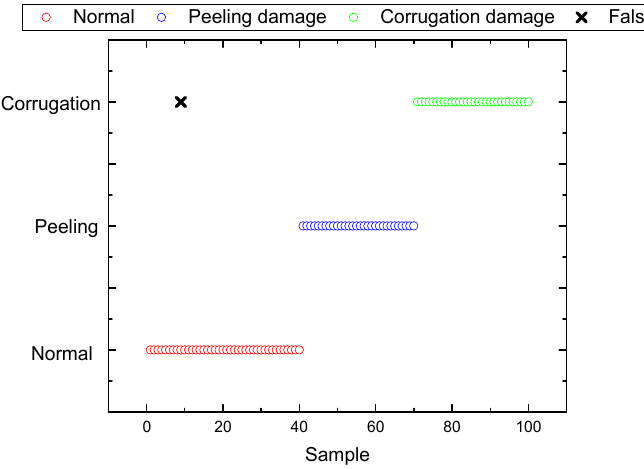
Figure 17. Identification accuracy of the proposed